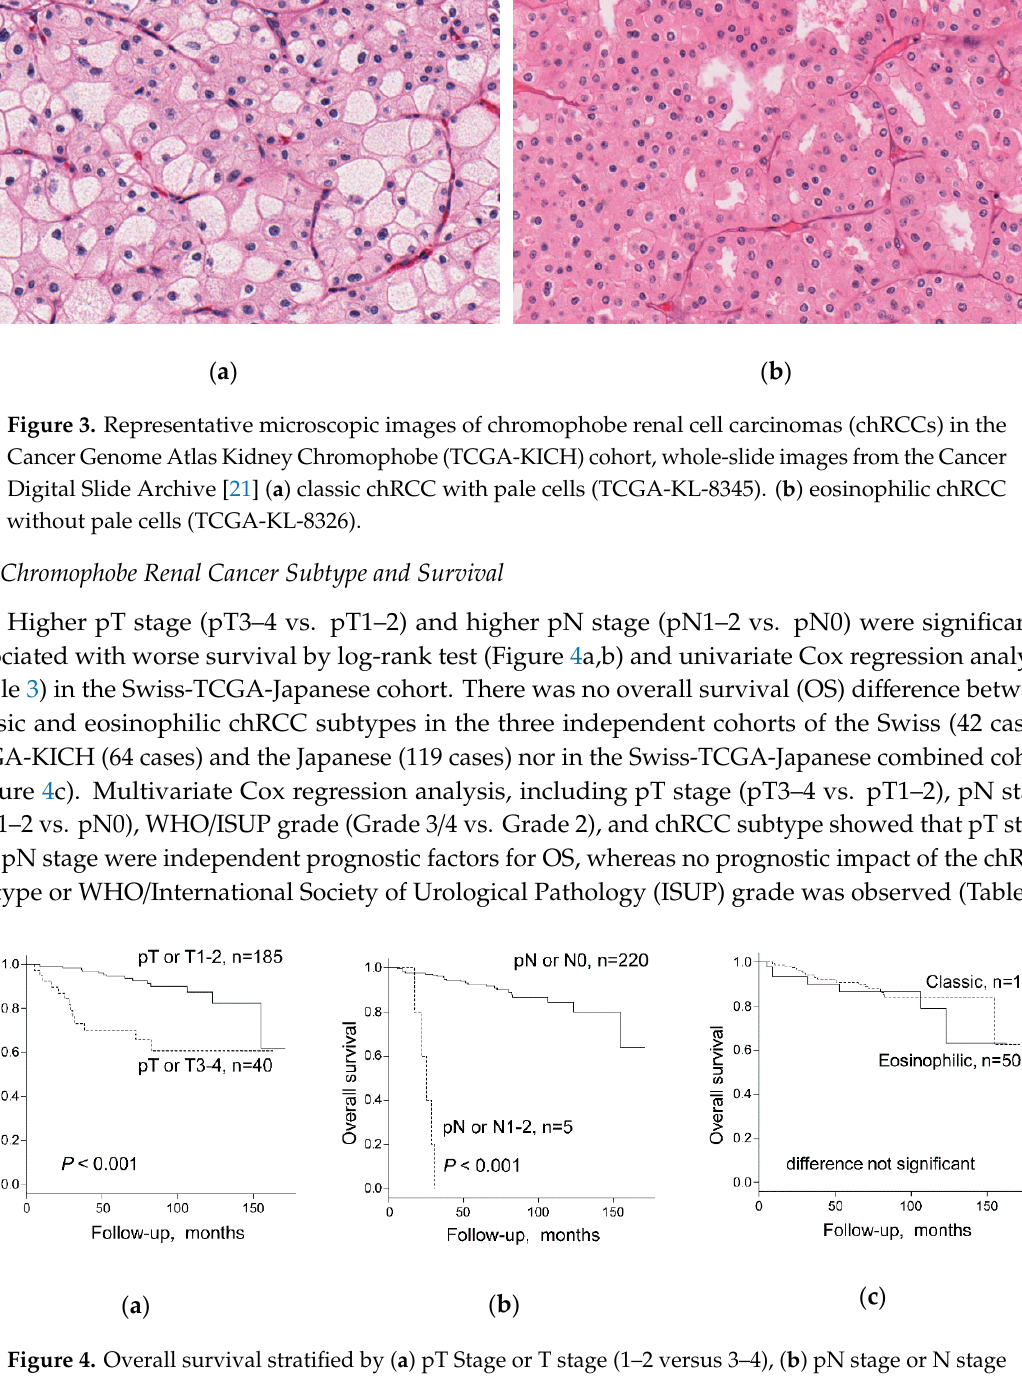
Figure 3. Representative microscopic images of chromophobe renal cell carcinomas (chRCCs) in the Cancer Genome Atlas Kidney Chromophobe (TCGA-KICH) cohort, whole-slide images from the Cancer Digital Slide Archive [21] ( a ) classic chRCC with pale cells (TCGA-KL-8345). ( b ) eosinophilic chRCC without pale cells (TCGA-KL-8326).